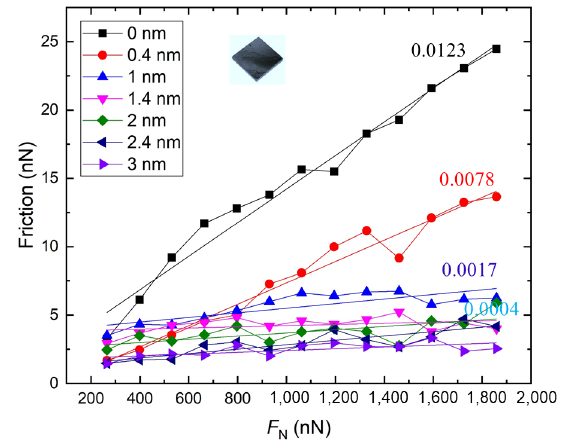
Fig. 5 Friction on the HOPG surface as a function of the applied normal load for different z -directional amplitudes (0, 0.4, 1, 2.4, and 3 nm) with a vibration frequency of 1